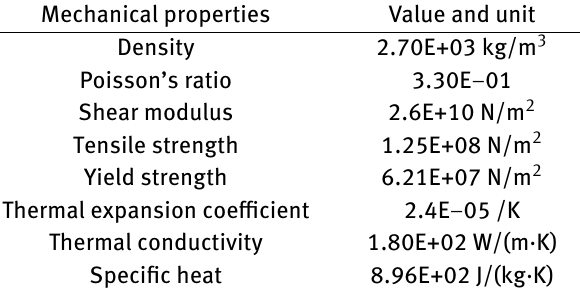
Table 1: Material properties of aluminium 6061-O Mechanical properties